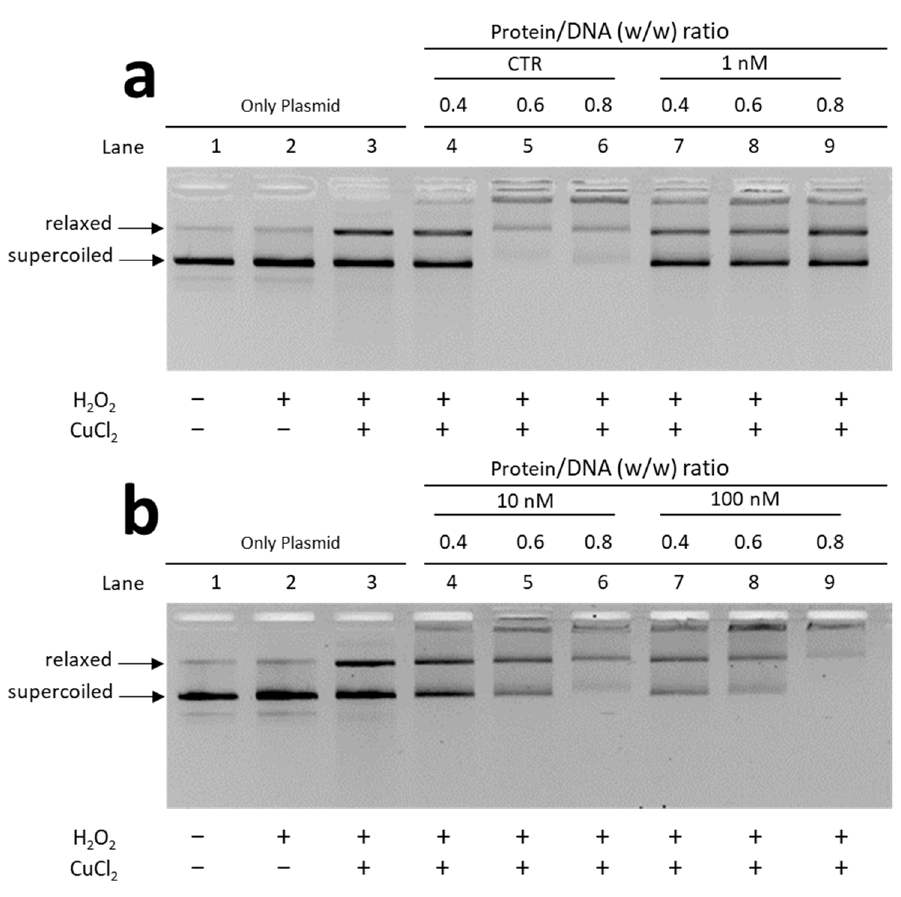
Figure 5. Protection assays with PL extracted from: unexposed (CTR) and exposed mussels to 1 nM chromium (VI) ( a ); exposed to 10 nM and 100 nM chromium (VI) ( b ). CTR = unexposed mussels.